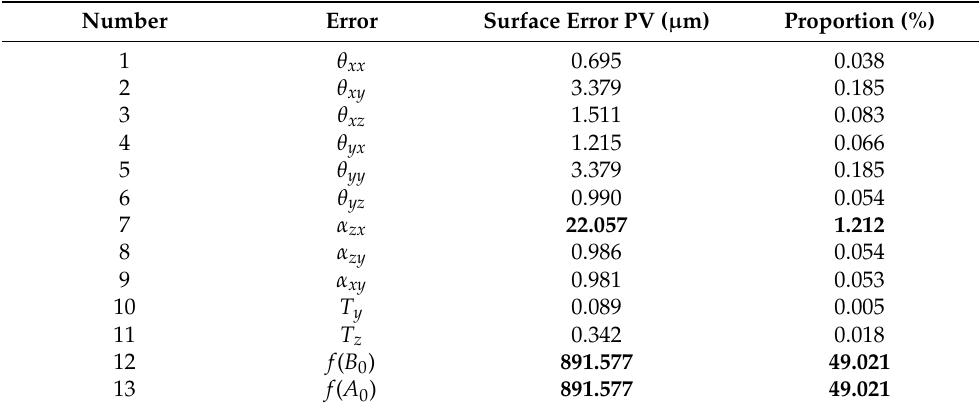
Table 2. The proportion of measurement system